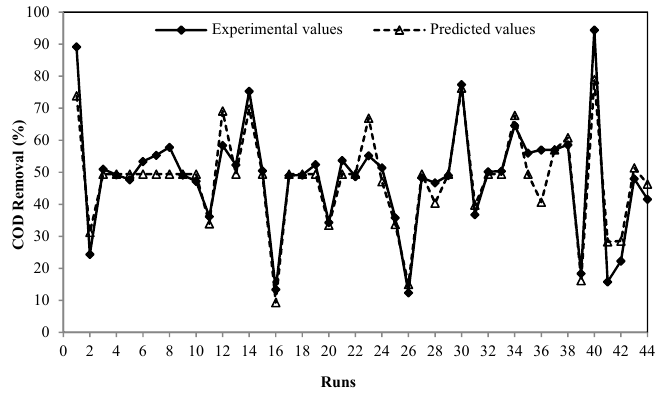
Figure 2. Comparison between experimental and prediction values for COD removal using the ANN method.